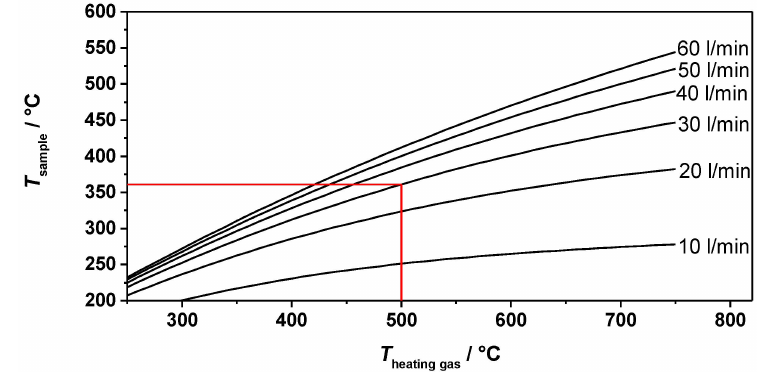
Figure 4. Results of the heating simulation: temperature of the sample as a function of the heating gas inlet temperature and the heating gas flow. The red line indicates the expected temperature using the available heating